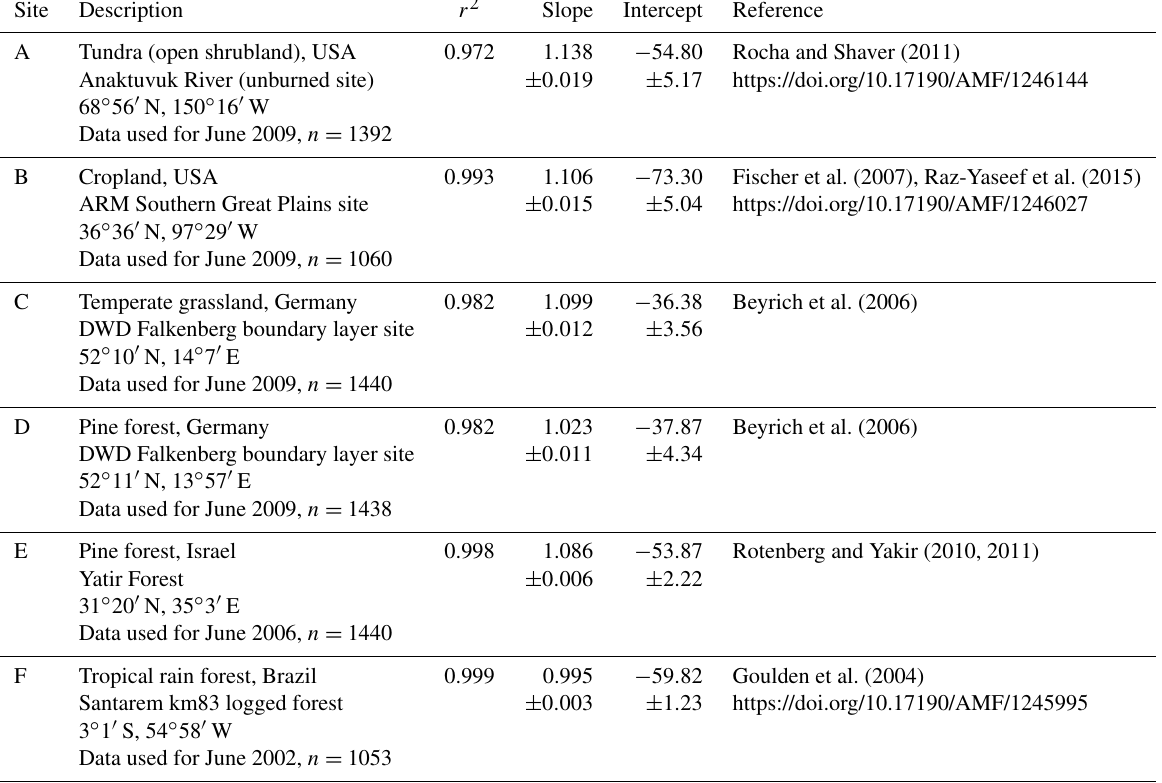
Table 2. Site description of the six sites used for evaluating the estimations of the maximum power limit (with the letters referring to the graphs shown in Fig. 3). Also shown are the correlation statistics of the comparison to observations. The adjusted squared explained variance of the linear regression of J opt to observed net radiation ( R n = R s − R l , net ) minus ground heat flux R n − d U s / d t is reported as r 2 . Standard error of slope and intercept of the regression are derived by a pre-whitening procedure to reduce the effect of serial correlation of the residuals (Newey and West, 1994; Zeileis,